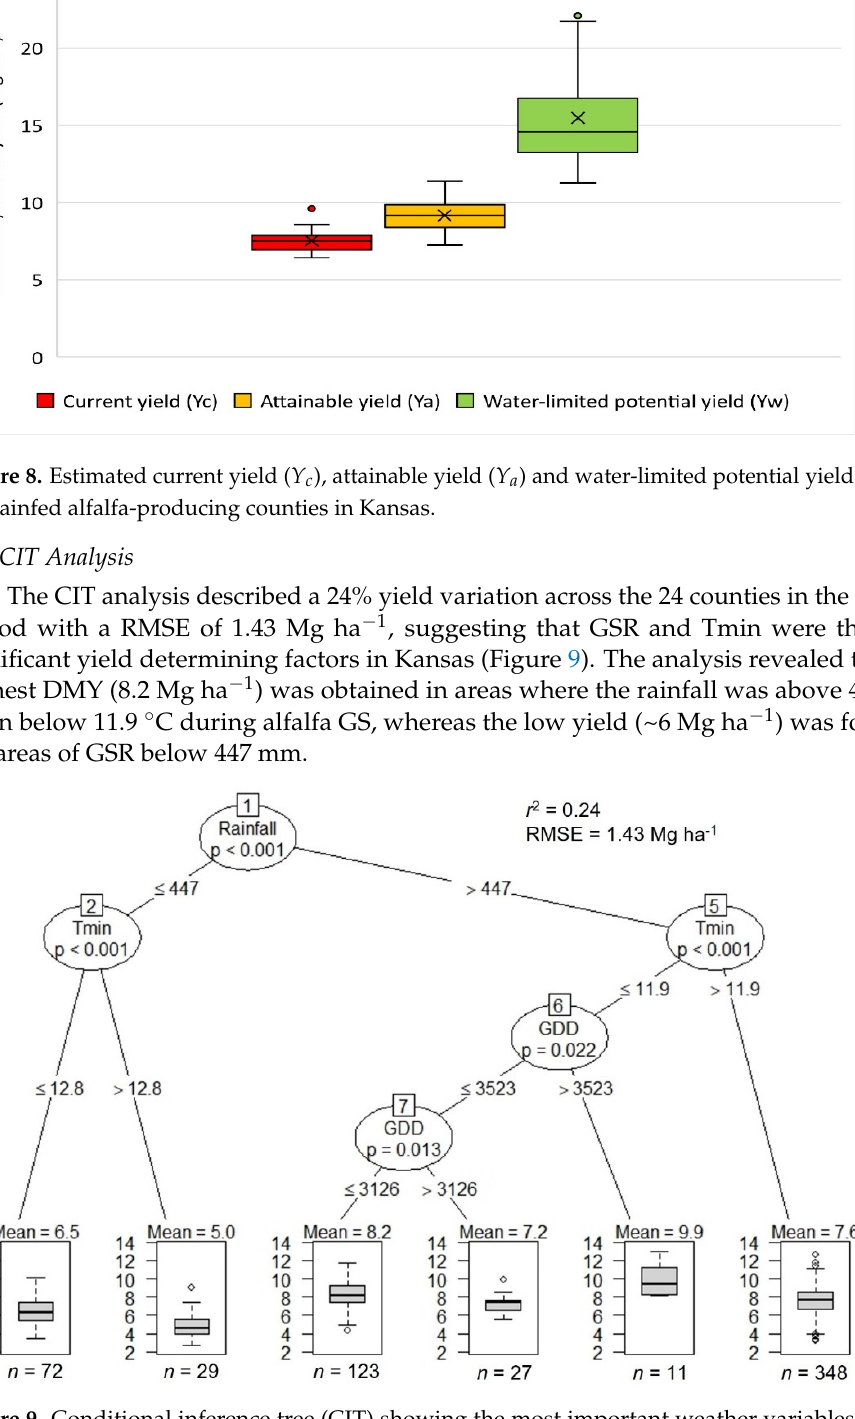
Figure 9. Conditional inference tree (CIT) showing the most important weather variables driving alfalfa yields in Kansas. The used weather variables were GS rainfall, GS maximum temperature (Tmax), GS minimum temperature (Tmin), and cumulative thermal units.